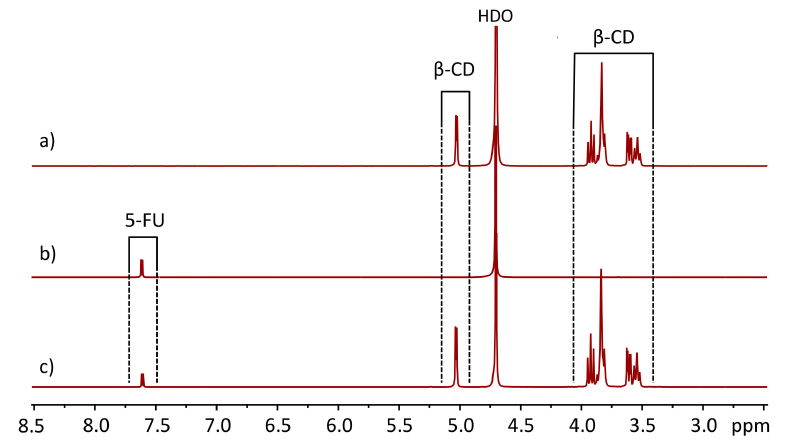
Figure 5. The 1 H NMR spectra (298 K) of solutions of ( a ) β -CD, ( b ) 5-FU and ( c ) their equimolar mixture in D 2 O.